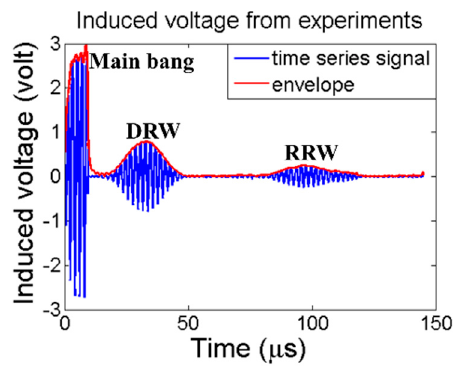
Figure 9. The received signal from experiments. The blue curve denotes the induced voltage in the received coil, and the red curve denotes the envelope of the received signal. Reproduced with permission from [15], IEEE, 2016.